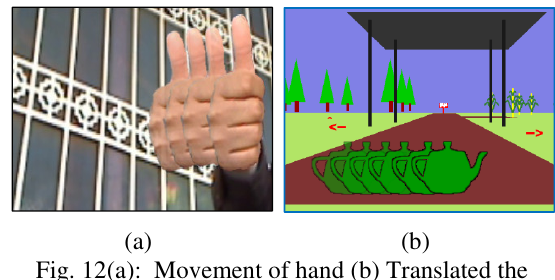
Fig. 12(a): Movement of hand (b) Translated the object along